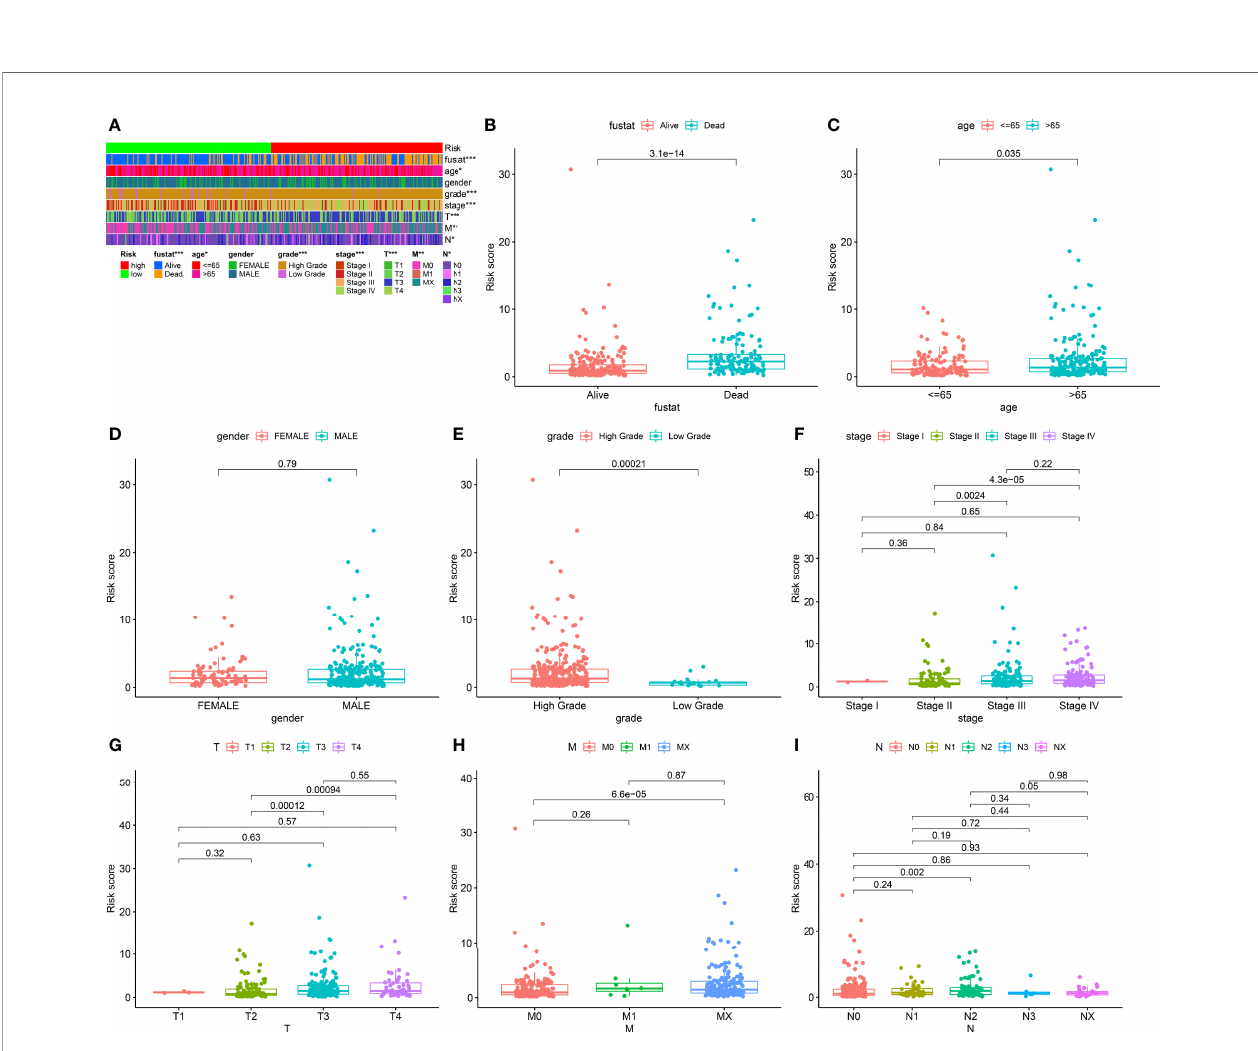
FIGURE 4 | A risk model for outcome prediction. (A) Risk score for each patient. (B) Survival outcomes for every patient. (C) Kaplan-Meier curves based on the status of survival of patients in high- and low-risk groups.